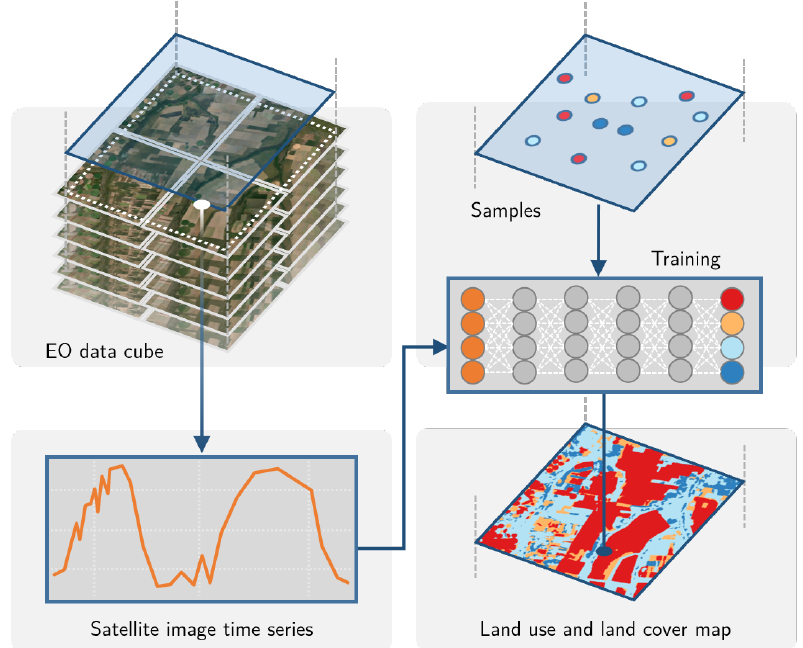
Figure 3. Using time series for land classification (source: authors). The above-described workflow represents one complete cycle of land use